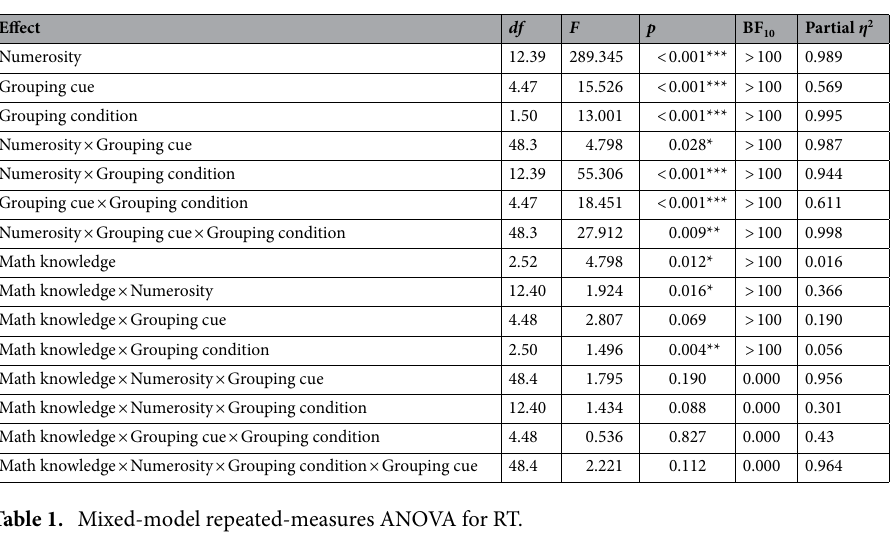
Table 1. Mixed-model repeated-measures ANOVA for